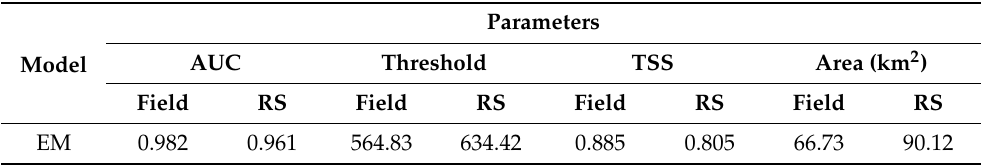
Table 2. Statistical parameters of model performances, thresholds applied to convert maps resulted from each modelling approach to binary maps and area suitable for C. sativa . All the parameters are means of ensemble model